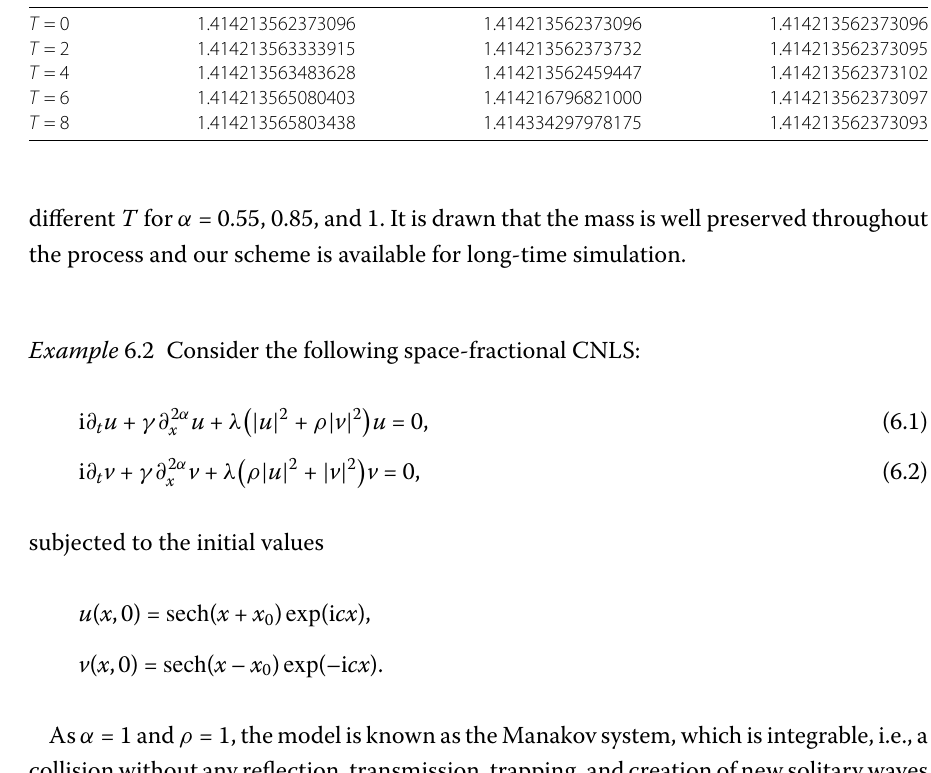
Table 2 The values of Q n u at different T for α = 0.55, 0.85, and 1 with τ = h = 0.05 α =